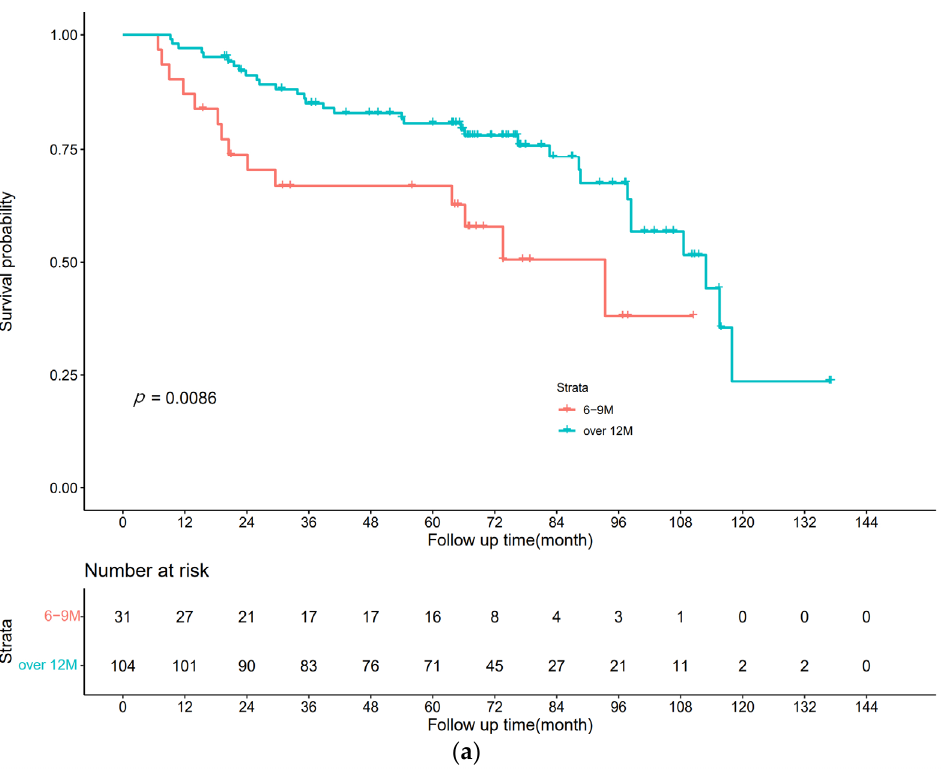
( b ) Figure 1. DFS. ( a ) Stage III CRC; ( b ) high-risk stage II CRC. 3.3. Overall Survival OS was based on 5.52 years of median follow-up.